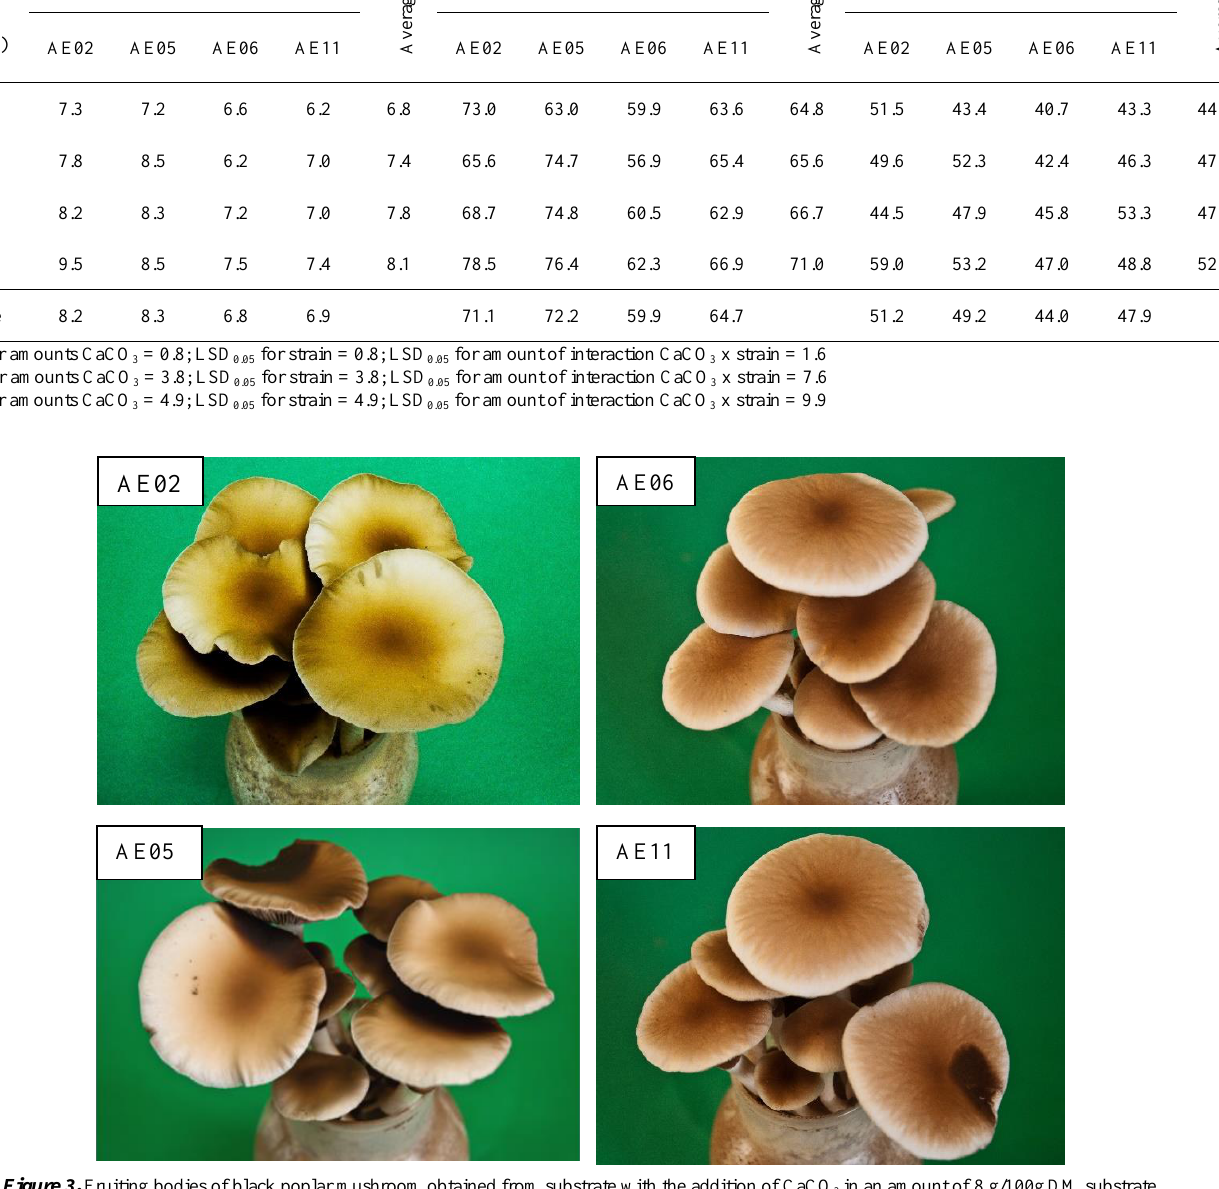
Figure 3. Fruiting bodies of black poplar mushroom obtained from substrate with the addition of CaCO 3 in an amount of 8 g/100g DM